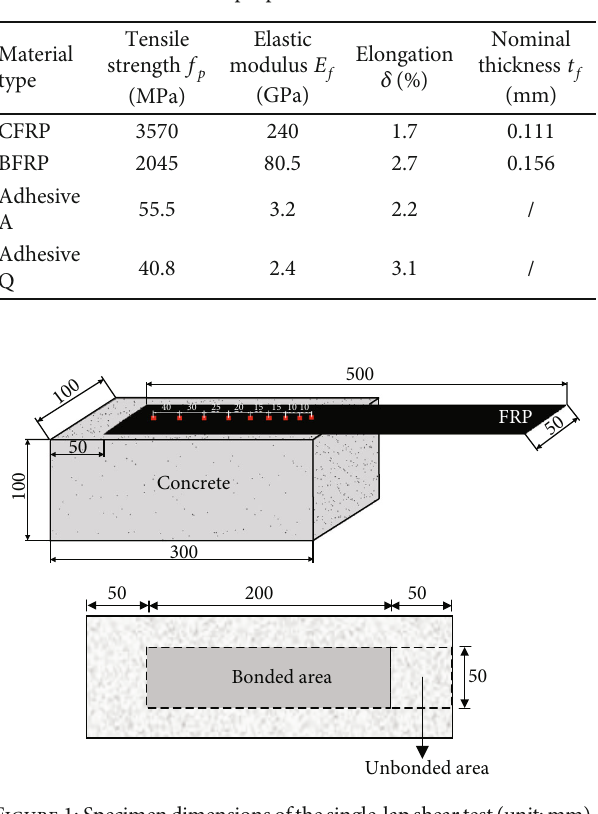
Table 3: Material properties of FRP and adhesive.